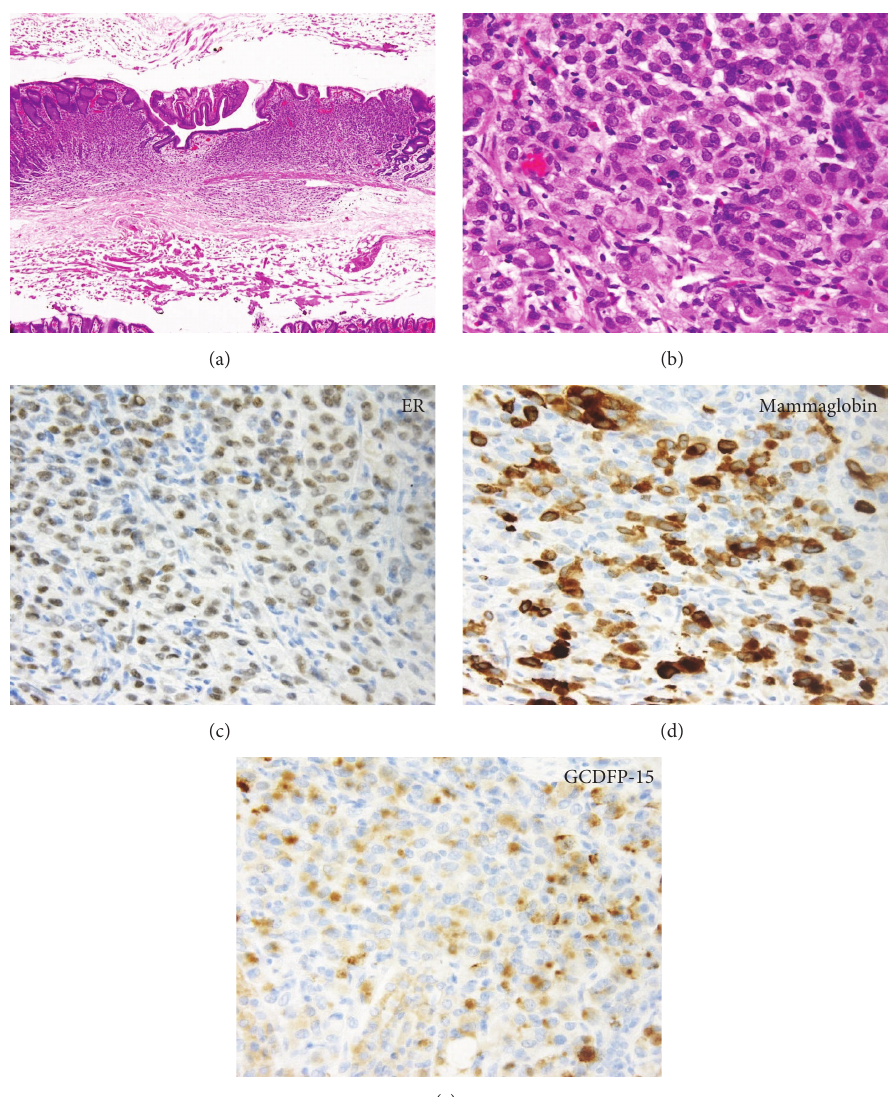
Figure 3: Histopathology of the tumor, which was localized within the mucosal layer to the submucosal layer.